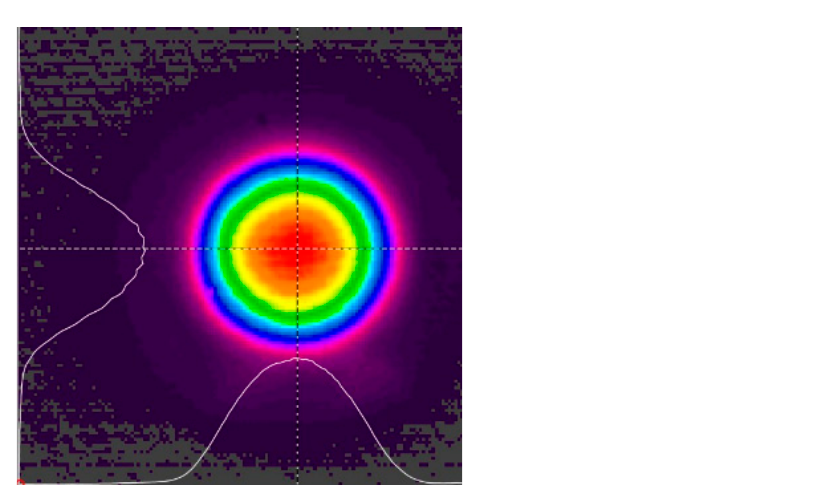
Figure 5. The intensity distribution of the Ho 3+ :YAG laser beam in the test plane.